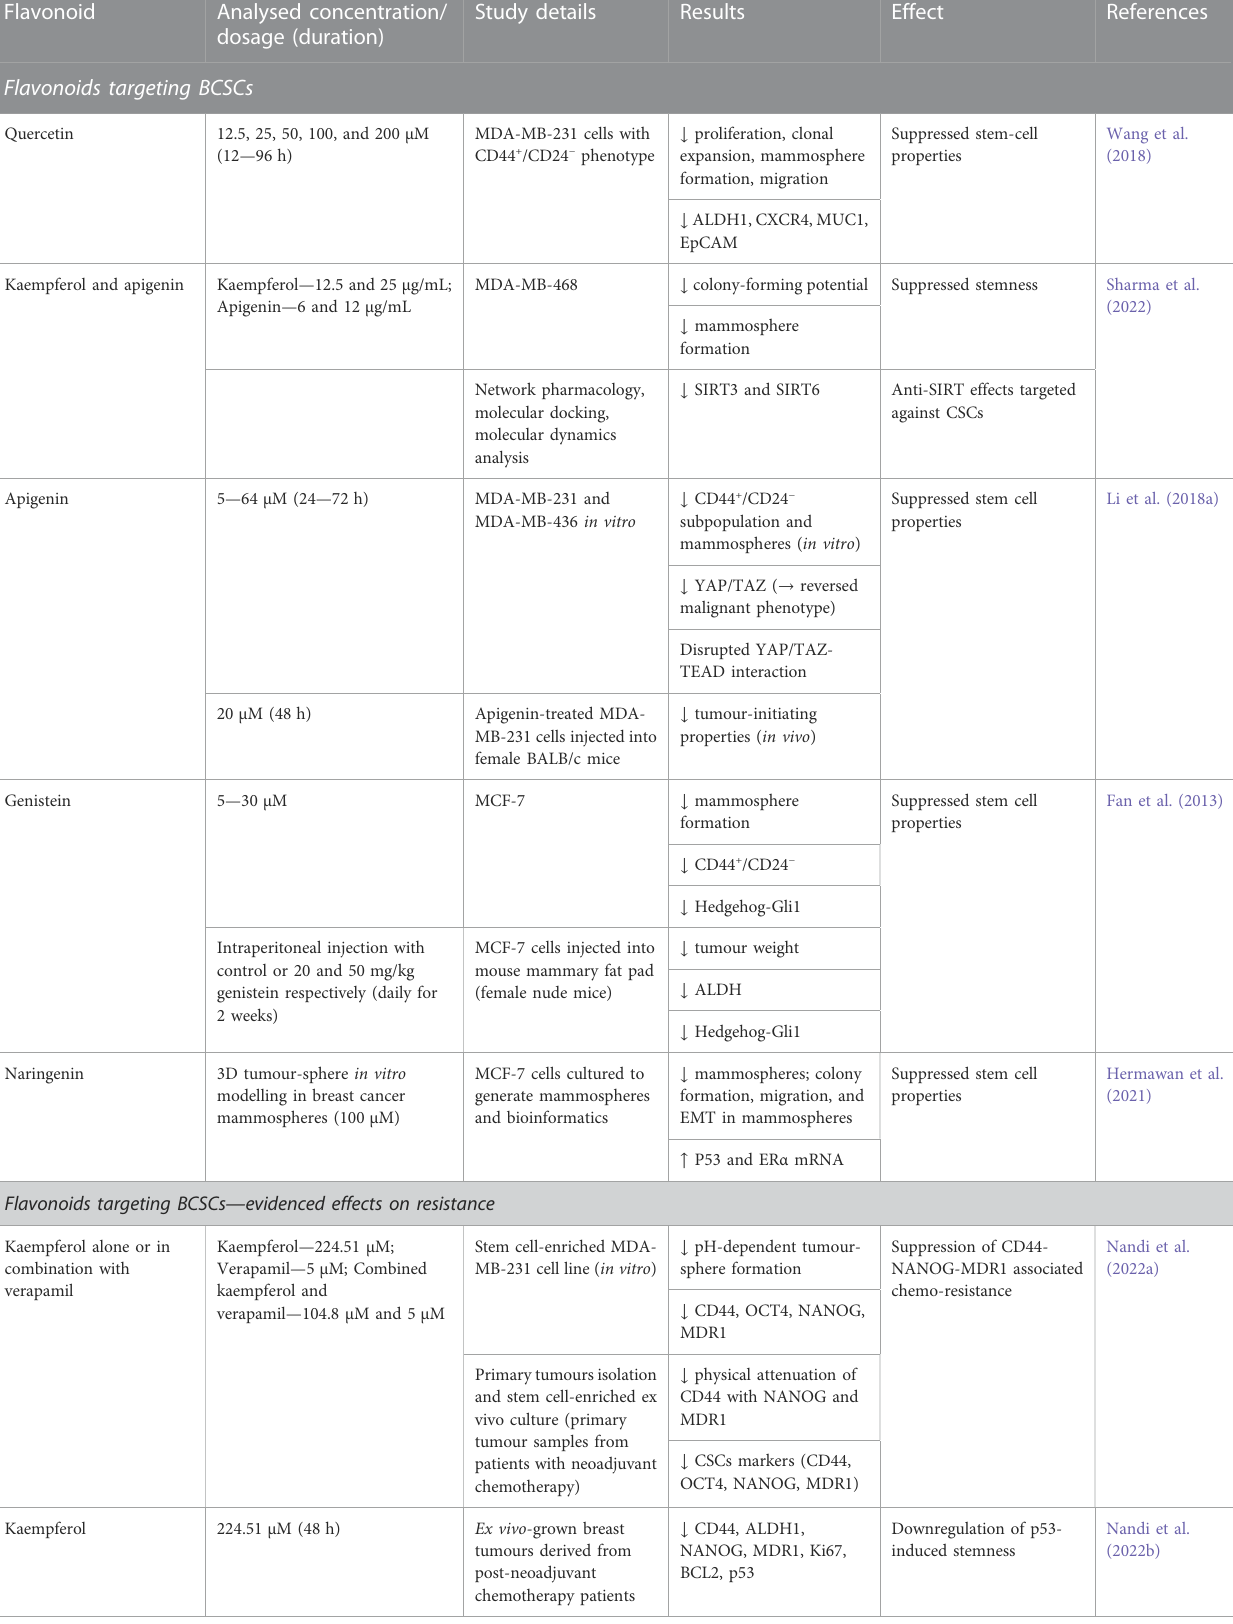
TABLE 2 Flavonoids targeting BCSCs to combat therapeutic resistance.